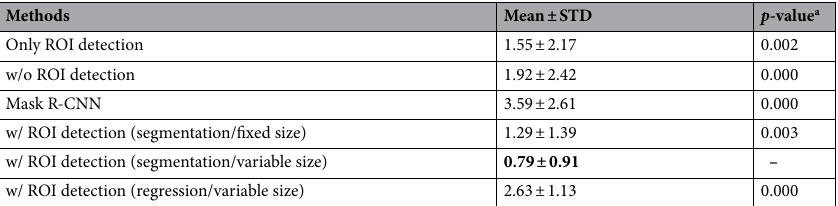
Table 2. Comparisons of distance error (mean ± STD, unit: mm) between predictions of the four different networks and the ground truth in the test set. ROI region of interest, STD standard deviation, w/o ROI detection landmark prediction without ROI detection, Mask R-CNN end-to-end model for ROI detection and landmark prediction with Mask R-CNN, w/ ROI detection (segmentation/fixed size or segmentation/variable size or regression /variable size) Landmark prediction with ROI detection of fixed or variable size. a The accuracy of w/ROI detection (segmentation/variable size) was compared with the other accuracies with paired t-test.